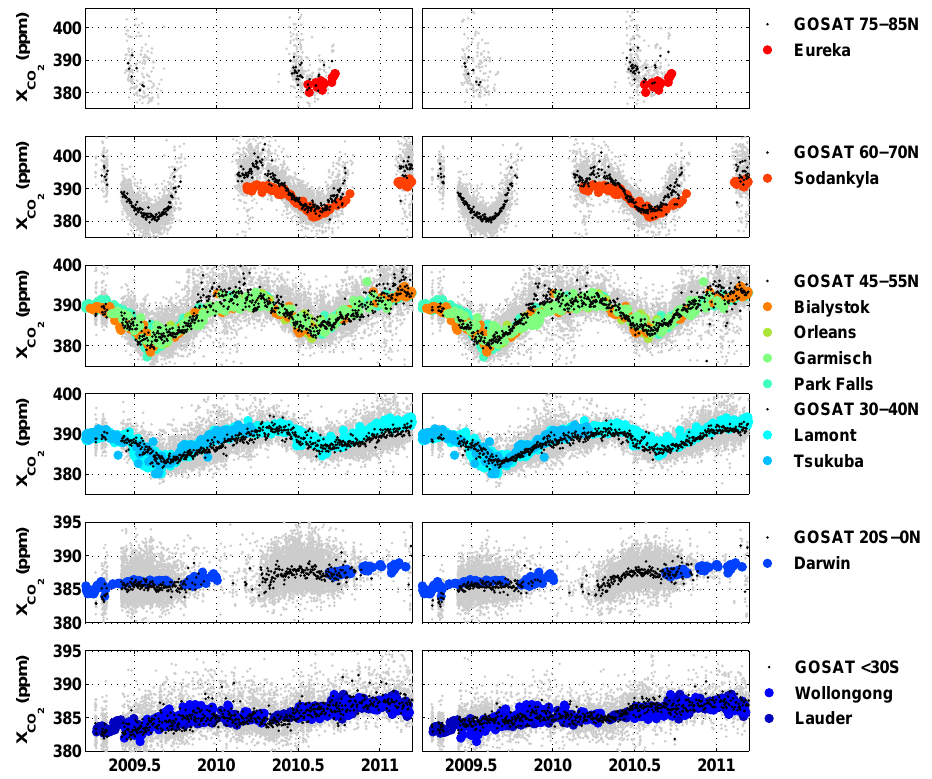
Fig. 13. Seasonal-cycle comparisons. These panels show the ACOS-GOSAT data adjusted by only the global bias (0.982, left panels) and after applying Eq. (4) (right panels). Each row of panels shows a different latitude range for the ACOS-GOSAT data (the black dots are the daily median zonal average values, and the grey dots are the individual measurements), and the TCCON daily median data within the latitude band (multi-coloured circles). The agreement and variability in the ACOS-GOSAT data are visibly improved in the right-hand panels.